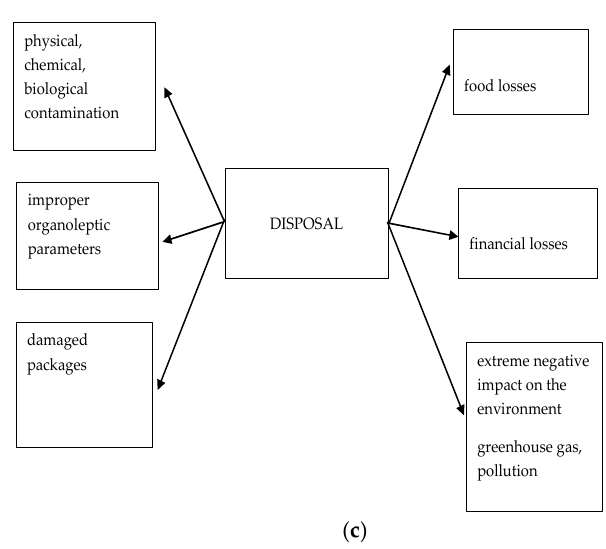
Figure 2. The bow tie analysis for reprocessing ( a ), hand over for feed ( b ), and disposal ( c ).